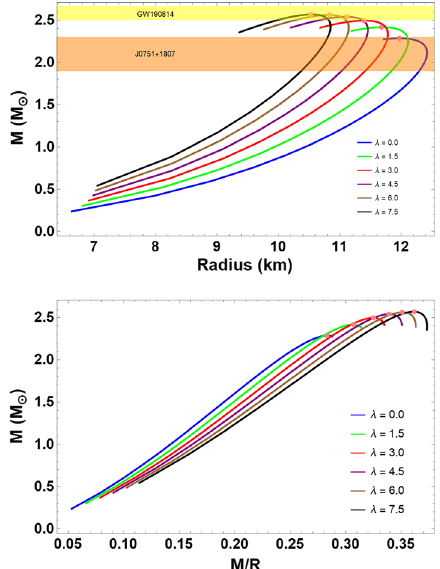
Fig. 1 Mass–radius ( M − R ) relation and compactness M − M / R for QSs have been plotted in the f ( R , T ) = R + 2 λ T gravity compared with GR considering the CFL EoS. For plotting the figures we have chosen B = 57 MeV/fm 3 , λ = 1 . 0, m s = 100 MeV and different values of λ = { 0 . 0 , 1 . 5 , 3 . 0 , 4 . 5 , 6 . 0 , 7 . 5 } , respectively. The horizontal barscorrespondtotheconstraintsimposedbythesecondarycomponent of the GW 190814 event (yellow) [35] and PSR J0751+1807 (orange) [36]. Each color represents a different M − R relation with parameters